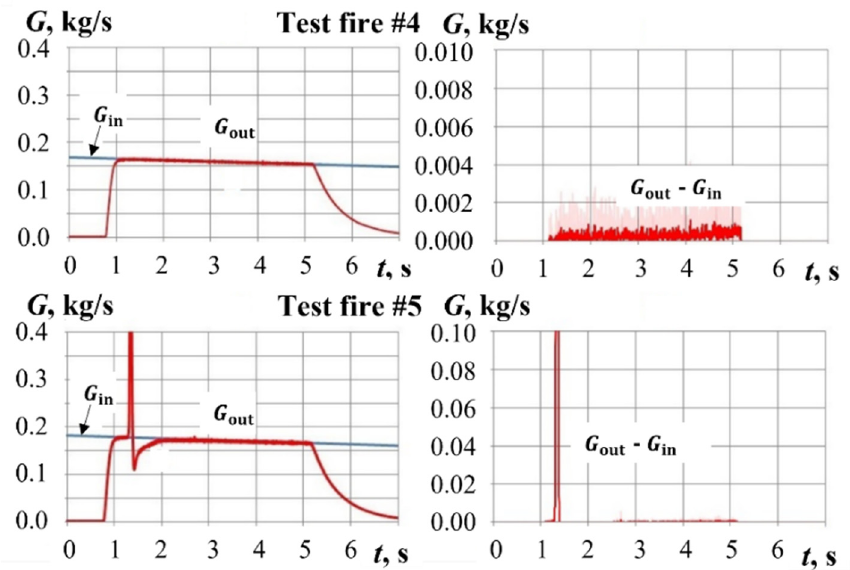
Figure 13. Calculated mass flow rates G in ( t ), G out ( t ), and G out ( t ) − G in ( t ) in test fires #4 and #5. In test fires #6 to #9, PP sample ignition and combustion in air flow was registered.